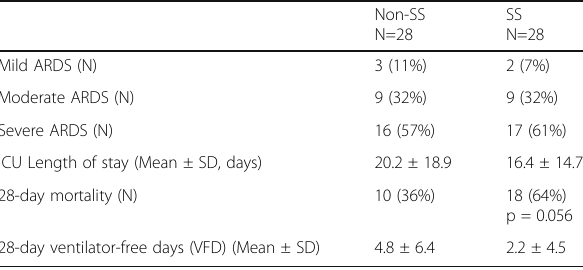
Table 1 (abstract 000977). ARDS severity: in non-SS and